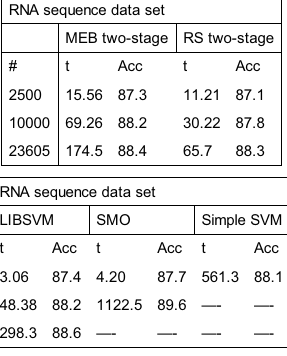
Table 4. Training time and accuracy comparison between different algorithms on RNA sequence data